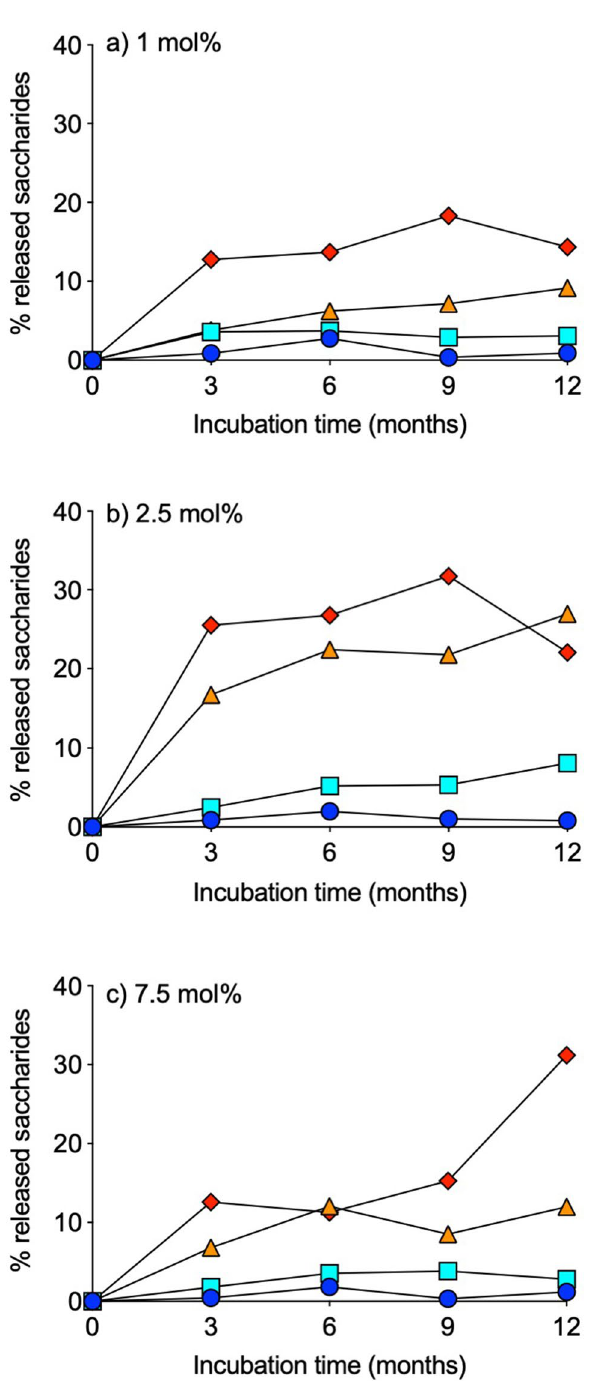
Figure 2. Release of free saccharides from dextrin–colistin conjugates with ( a ) 1 mol%, ( b ) 2.5 mol% and ( c ) 7.5 mol% succinoylation following storage at − 20 (dark blue circle), 4 (light blue square), 21 (orange triangle) or 37 (red diamond)°C for up to 12